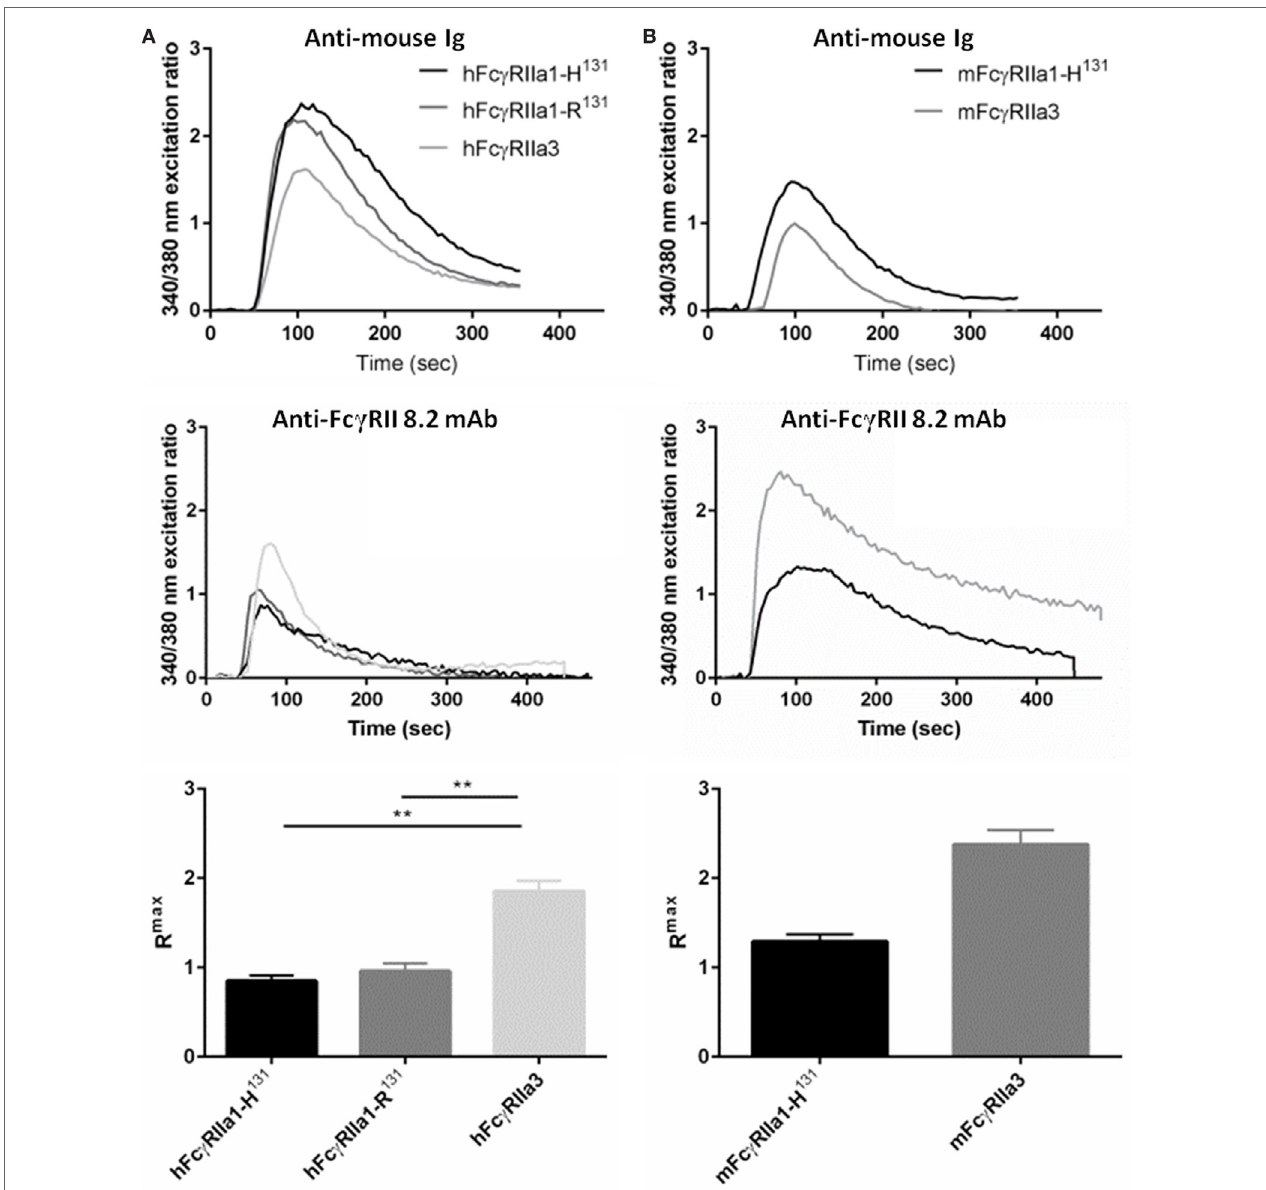
FigUre 5 | Fc γ RIIa3 induced greater calcium mobilization. Calcium mobilization in IIA1.6 cells expressing (a) human and (B) macaque Fc γ RIIa3 or Fc γ RIIa1 allelic variants. Cells loaded with fura-2/AM were stimulated at 37°C with agonistic anti-receptor mAb 8.2 or anti-Ig agonist (10 µg/mL), and response measured for 500 s. Representative 340/380 nm excitation ratios indicative of calcium mobilization with background subtracted. R max values were compared to determine peak calcium mobilization levels (mean ± SEM, n =